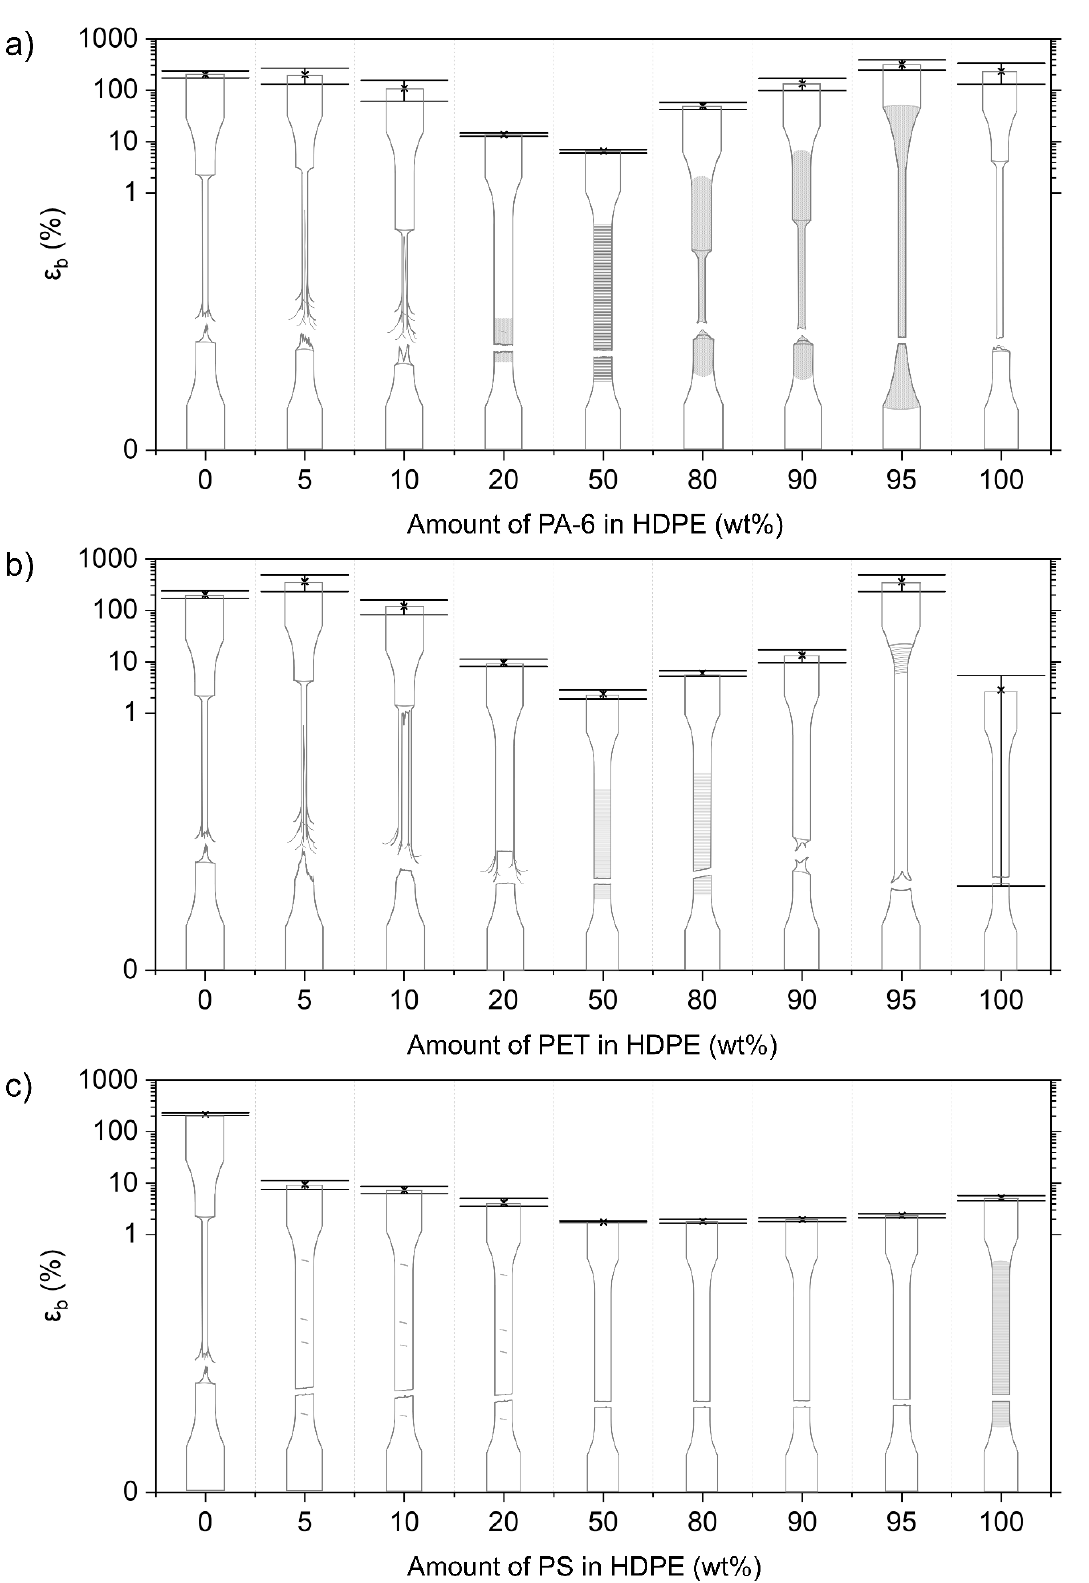
Figure 6. Overview of the deformed samples after tensile testing and respective ε b values for the HDPE blends combined with ( a ) PA-6, ( b ) PET, and ( c ) PS. Crazing is indicated as fine mark lines for the neat PS. Other shading points to stress whitening, which is visible during/after tensile testing. Coarser markings and lines indicate local points of necking initiation.